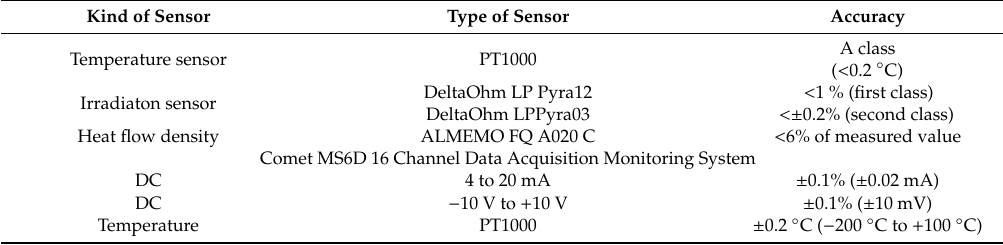
Table 1. Measurement accuracy of employed sensors and Data Acquisition Monitoring System.